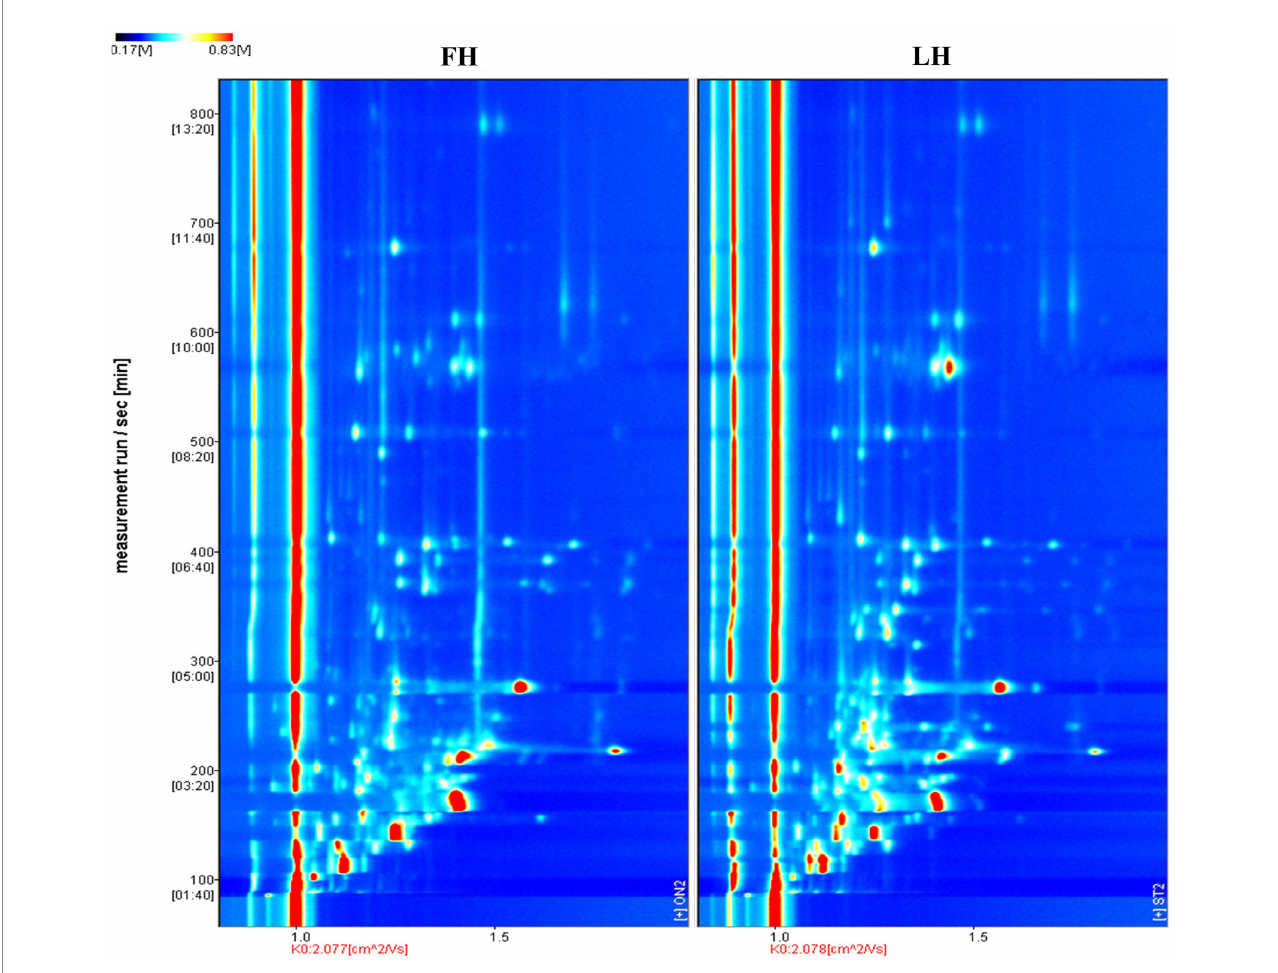
FIGURE 2 Comparison of volatile flavor profiles of Jinhua FH and LH with two-dimension HS-GC-IMS spectra. FH, fatty ham; LH, lean